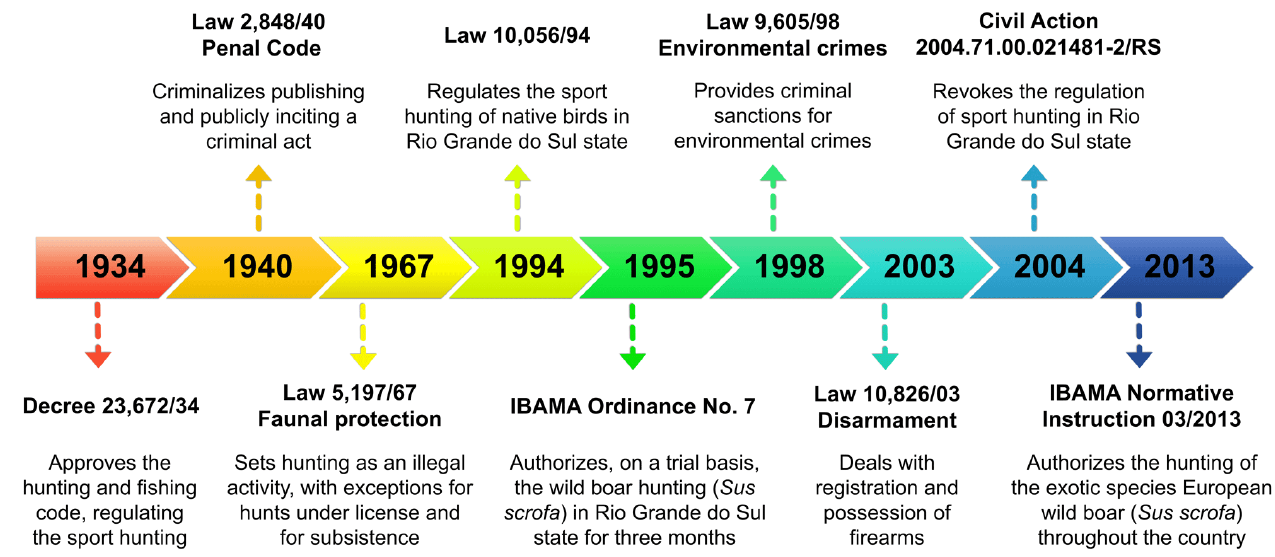
Fig. 1 . Timeline of the creation of legislation regulating hunting activity in